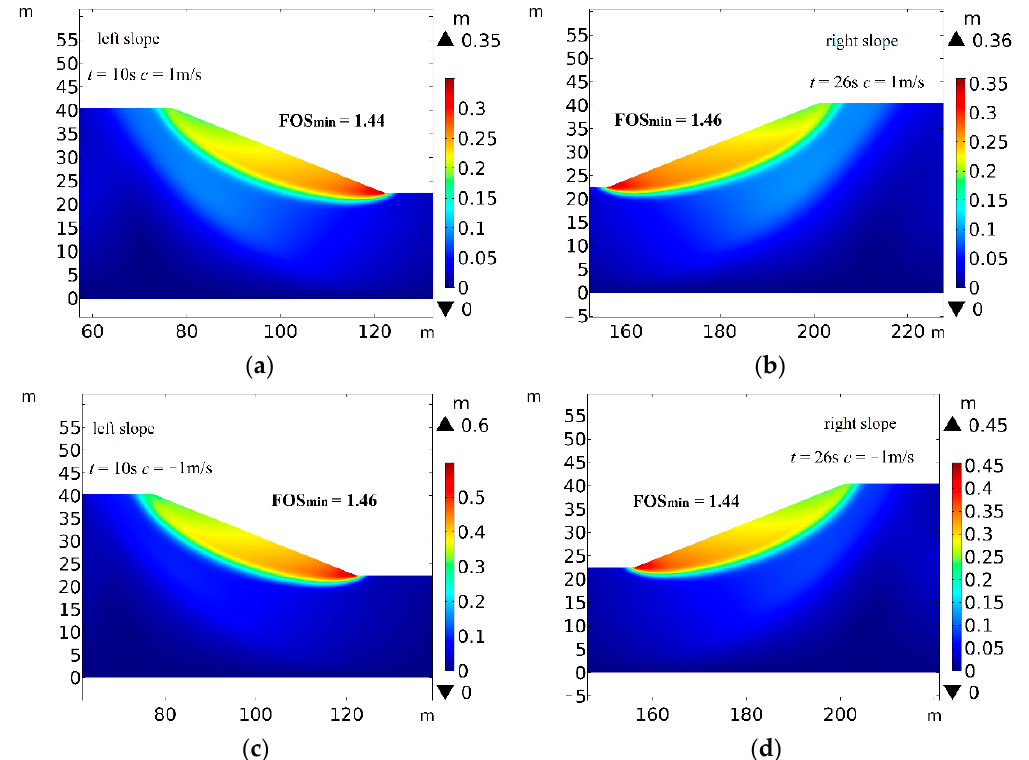
Figure 10. Deformation of the trench slopes under the currents in different directions: ( a ) left slope, 1 m/s; ( b ) right slope, 1 m/s; ( c ) left slope, − 1 m/s; ( d ) right slope, − 1 m/s.